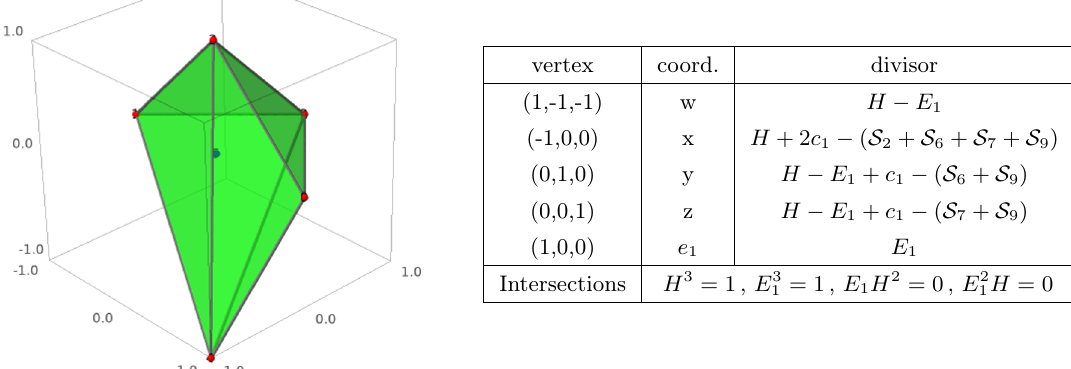
Figure 4 . The polytope and data associated to the ambient space Bl 1 P 3 of nef (5,1). The latter generically leads to a rank one Mordell-Weil